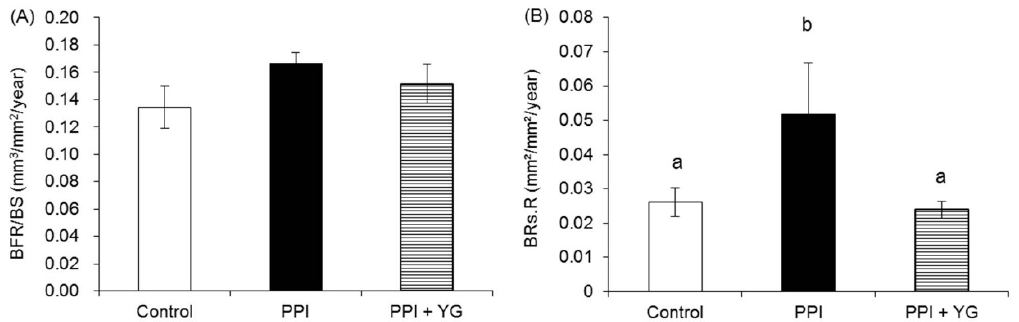
Figure 2. Effects of proton pump inhibitor (PPI) administration and the intake of a combination of yogurt and galactooligosaccharides (YG) on dynamic bone histomorphometry of proximal tibial metaphysis in adult rats. ( A ) Bone formation rate/bone surface (BFR/BS); ( B ) Bone resorption rate (BRs.R). Values are presented as the mean ± SE. a, b: bars with different letters are significantly different ( p < 0.05).